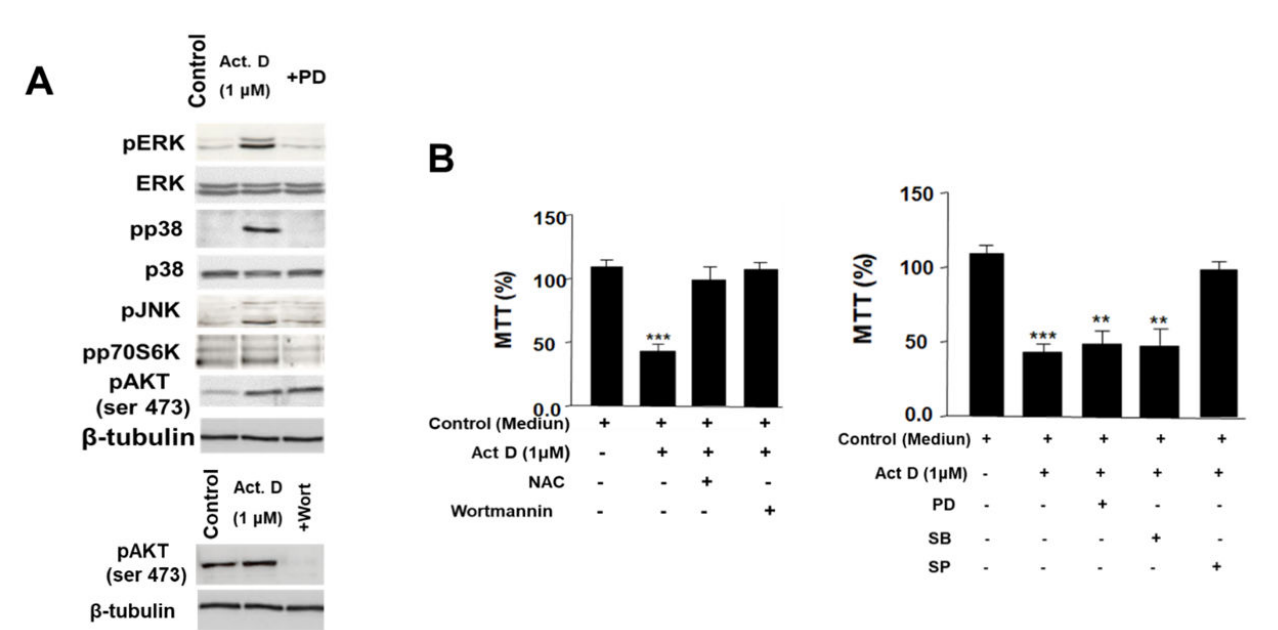
Figure 3. ( A ) Study of the MAP kinases and AKT pathways by immunoblot in HepG2 cells treated with ActD (1 µ M) alone or combined with PD98059 or wortmannin for 24 h. ( B ) Effect of different inhibitors on the metabolic activity (MTT) of HepG2 cells during treatment with ActD (1 µ M) for 24 h. The experiments from panel ( A ) are representative of three others with similar results. PD = PD98059; Wort = Wortmannin. SP = SP600125; SB = SB203580; NAC = N -Acetyl-L-cysteine (1 mM). β -tubulin was used as loading control of SDS-PAGE. Significance levels: ** p < 0.01; *** p <